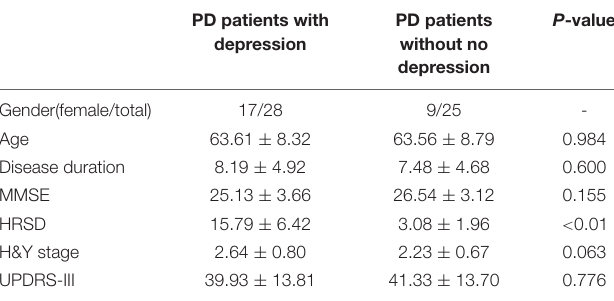
TABLE 1 | Demographic and clinical characteristics of all